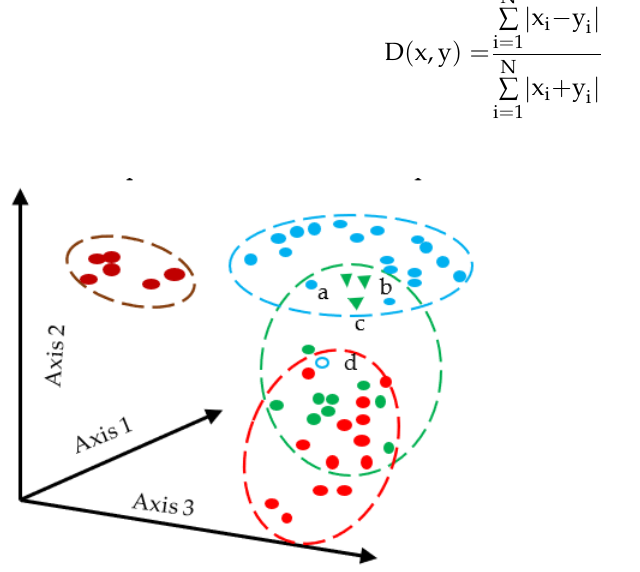
Figure 1. Schematic Diagram of Bray–Curtis Distance Measures, a–d represents the sampling point. Here N represents the no of data points, and y is the point.